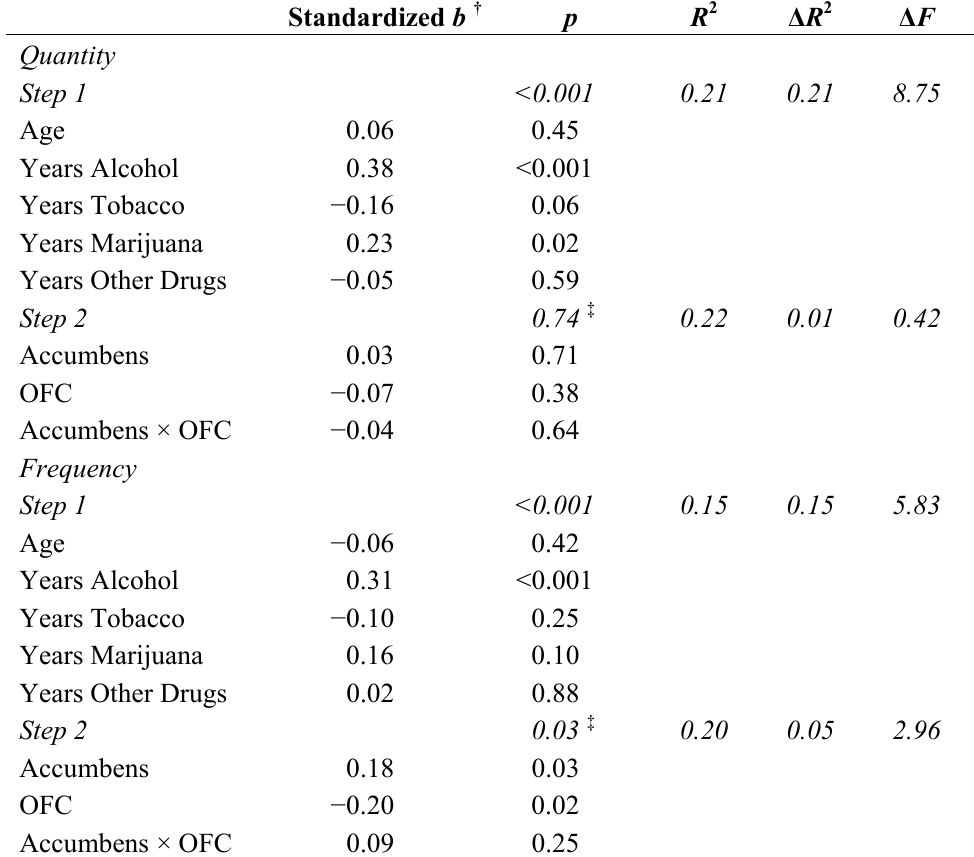
Table 2. Hierarchical regression of past 3-month alcohol